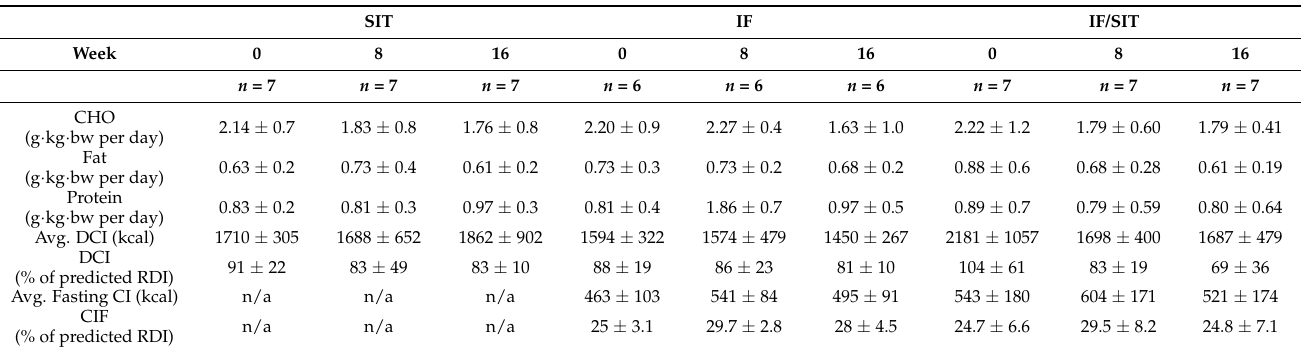
Table 5. Participants’ self-reported total calorie and macronutrient intakes during the diet and/or exercise